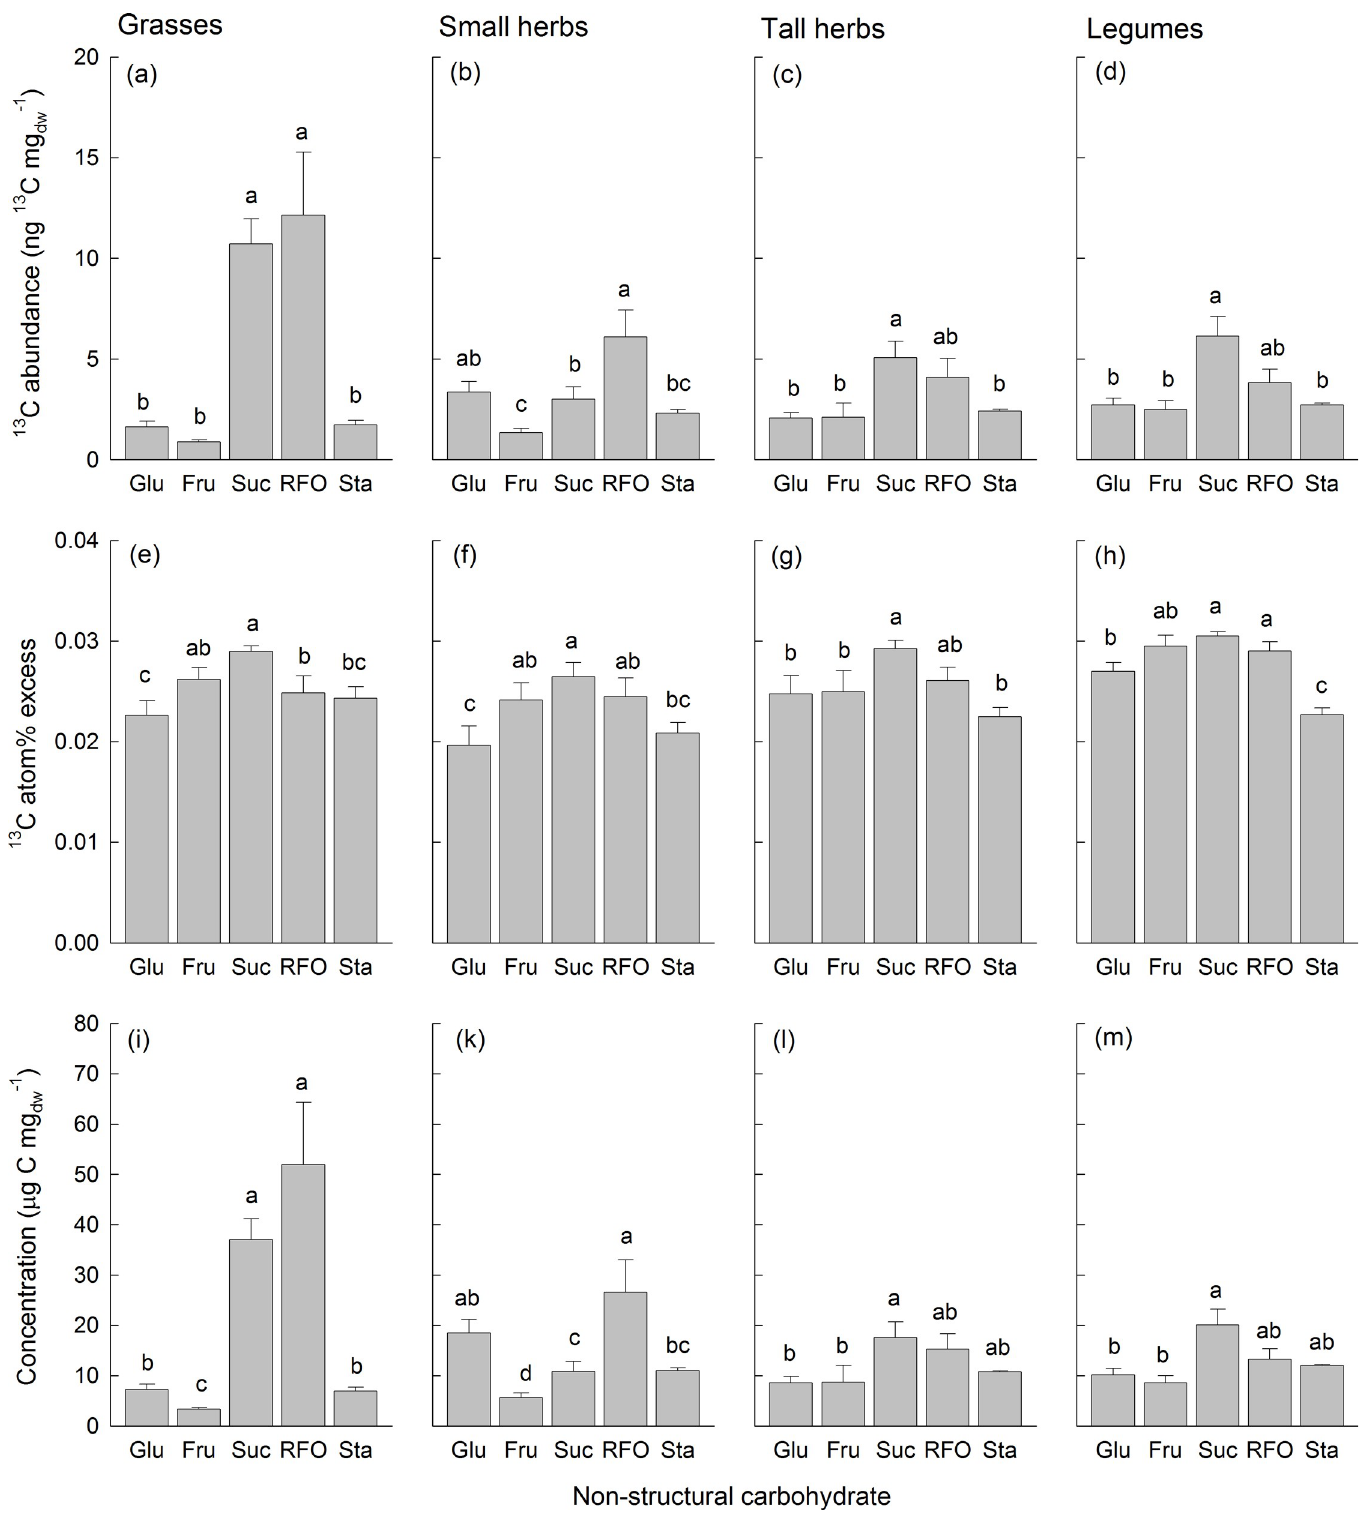
Fig 5. Concentrations and δ 13 C of different non-structural carbohydrates. 13 C abundances (a-d), 13 C atom% excess (e-h), and concentrations (i-m) for non-structural carbohydrates in leaves of grasses (a, e, i), small herbs (b, e, k), tall herbs (c, f, l), and legumes (d, h, m). Shown are means (+1 SE) across all mixtures. Results of Tukey‘s test applied (P < 0.05) to test for significant differences among non-structural carbohydrates are indicated with letters. Abbreviations are: Glu = glucose, Fru = fructose, Suc = sucrose, RFO = raffinose-family oligosaccharides, Sta = starch. https://doi.org/10.1371/journal.pone.0204715.g005 PLOS ONE | https://doi.org/10.1371/journal.pone.0204715 January 31,